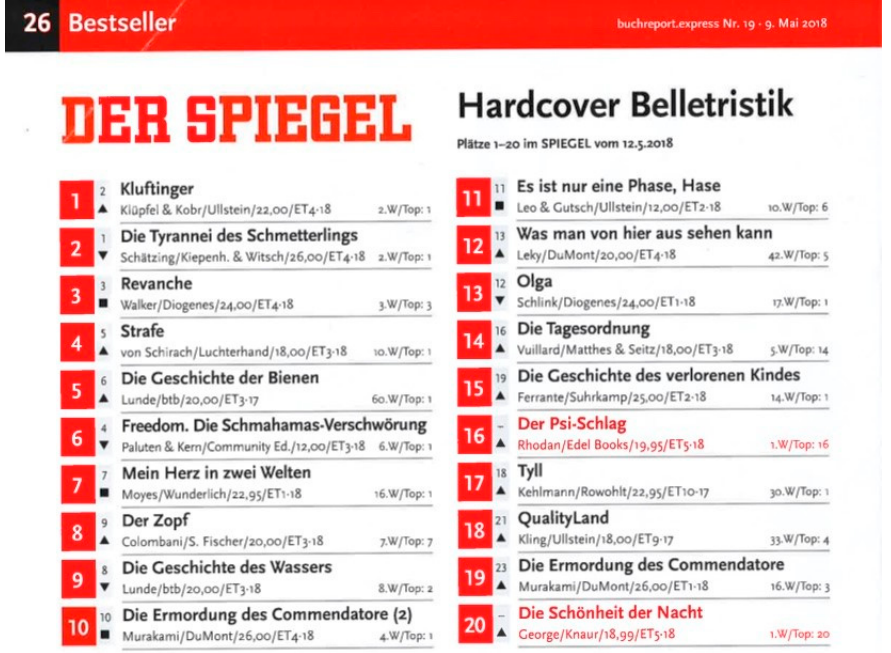
Figure 5. Spiegel bestseller list Hardcover Belletristik from 19 May 2018. The Perry Rhodan volume ranks at place 16 behind Elena Ferrante and before Daniel Kehlmann, a representative of “high culture,” who has been honored with renowned poetry and literature awards.